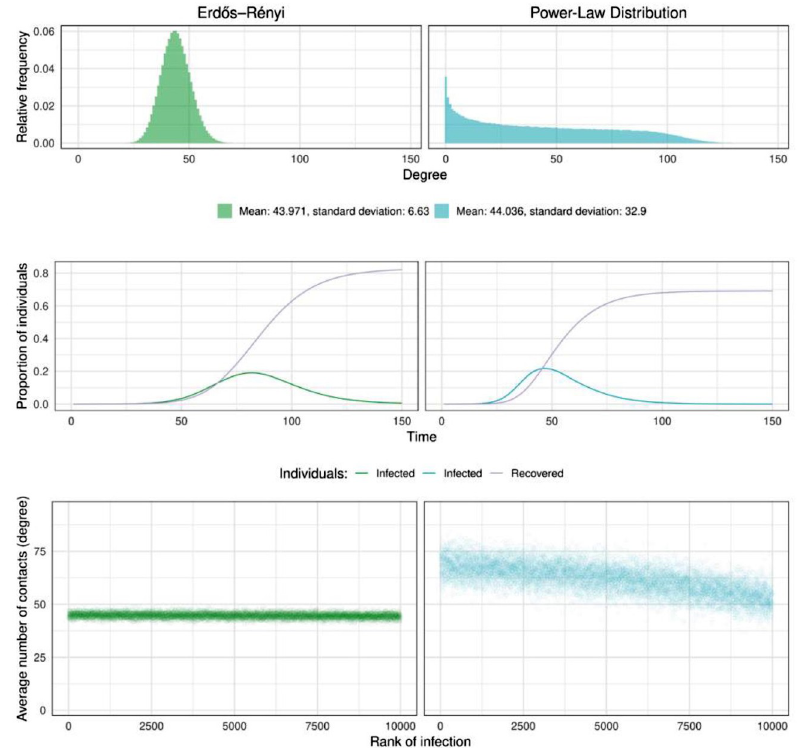
Fig 1. Two different ways of modeling social interactions. Top panels represent the distribution of the number of risky interactions in the Erd ő s-Re´nyi and the Power Law graphs with 20000 individuals. For a better visualization of the Power Law degree distribution, in a log-log scale, see S1 Fig. Panels in the middle show a realization of the SIRD process for each of the models. Bottom panels show the number of risky interactions individuals have, as a function of the order in which they are infected (dots show the average over 30